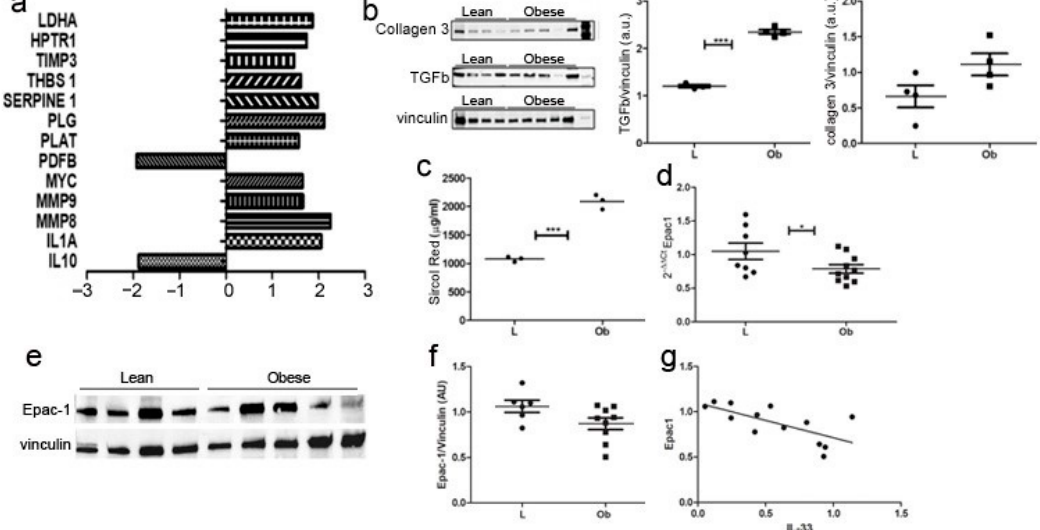
Figure 3. Fibrotic cardiac remodeling evaluation in obese Zucker rat. ( a ) The graph showed fibrosis- related transcriptome in ZF rats. Genes that showed a fold change >2 or <-2 in the Ob vs. L group are represented and grouped according to their biological function ( p < 0.01). ( b ) Western blot showed upregulation of collagen 3 and TGF- β in Obese rats. ( c ) Graph showing Sircol red quantification demonstrated significant over-expression in Obese rats related to control ones ( p = 0.0002). Graphs showed Epac-1 over-expression in ( d ) qPCR and ( e ) proteomic experiments, as shown by representative blot and ( f ) densitometric analysis. ( g ) A negative correlation was evidenced between Epac1 and IL-33 expression Student’s t -test: * p < 0.05; *** p < 0.001. Full square stands for Obese rats, while full circle stands for Lean rats